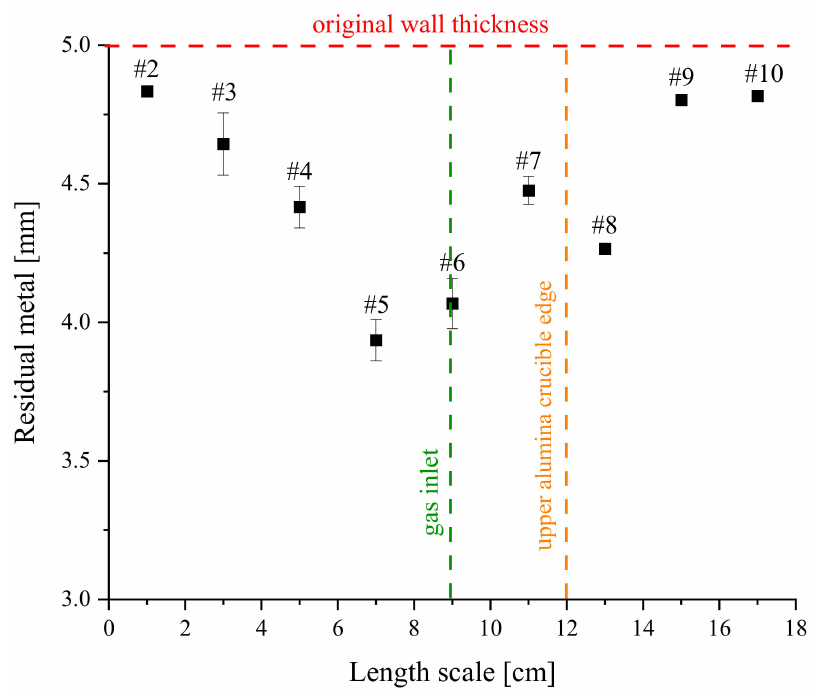
Figure 2. Average residual metal wall thickness was measured for samples taken at different heights in the vessel. The location of the gas inlet and the upper edge of the salt-filled alumina crucibles are highlighted (see schematic in Figure